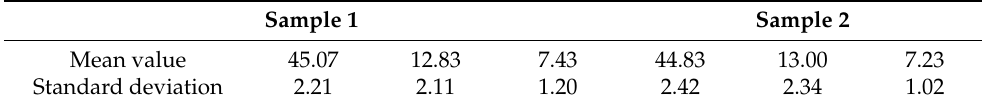
Table 5. Results of measurements of the homogeneity of selected acoustic properties of samples made using additive manufacturing technology (the complete set of results are available in the Appendix A in Table